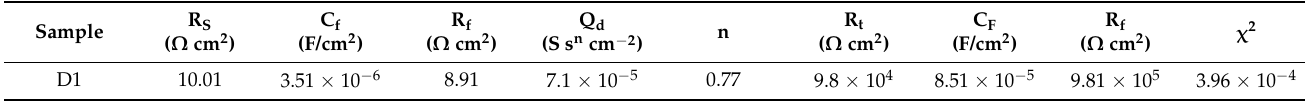
Table 2. The values of the equivalent circuit for D1.